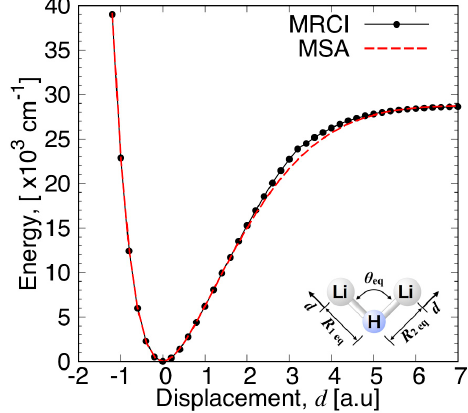
Figure 5. Potential energy curve for the symmetric stretch of Li 2 H at the equilibrium angle.